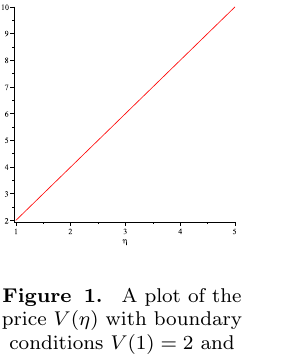
Figure 1. A plot of the price V ( η ) with boundary conditions V (1) = 2 and V (5) = 10.